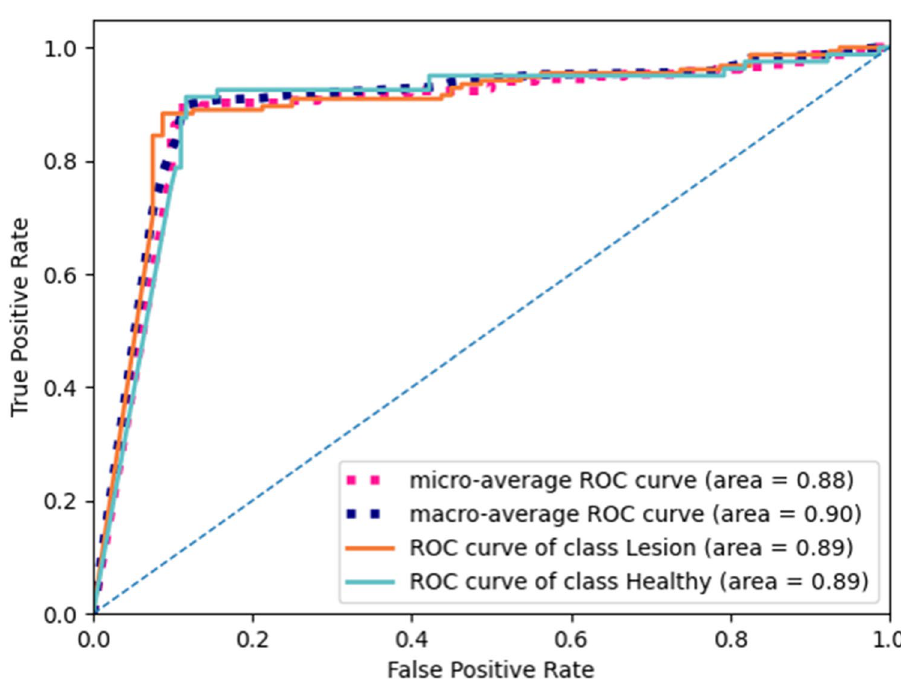
Figure 4. The ROCs and AUC scores of the binary classification. Lesion and healthy samples achieve the same AUC